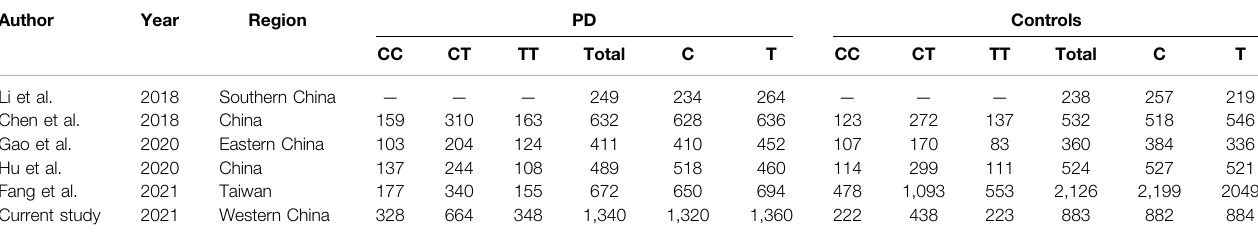
TABLE 5 | Characteristics of the included studies for the association between IL1R2 rs34043159 and PD in